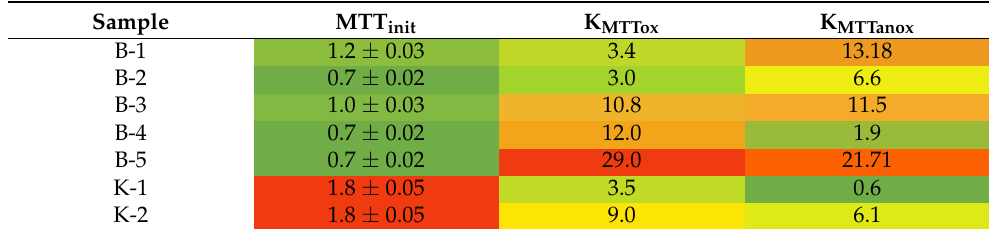
Table 6. Heatmap of the coefficients of increased microbial respiration in clay samples before and after stimulation by acetate and